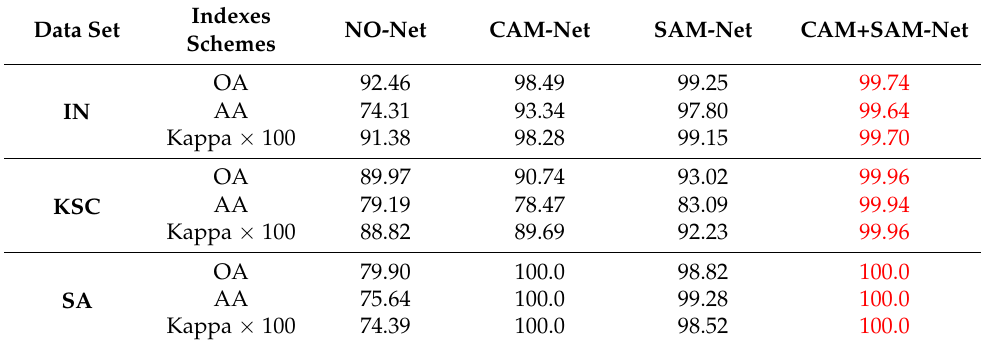
Table 10. The effect of attention module for three HSI datasets.